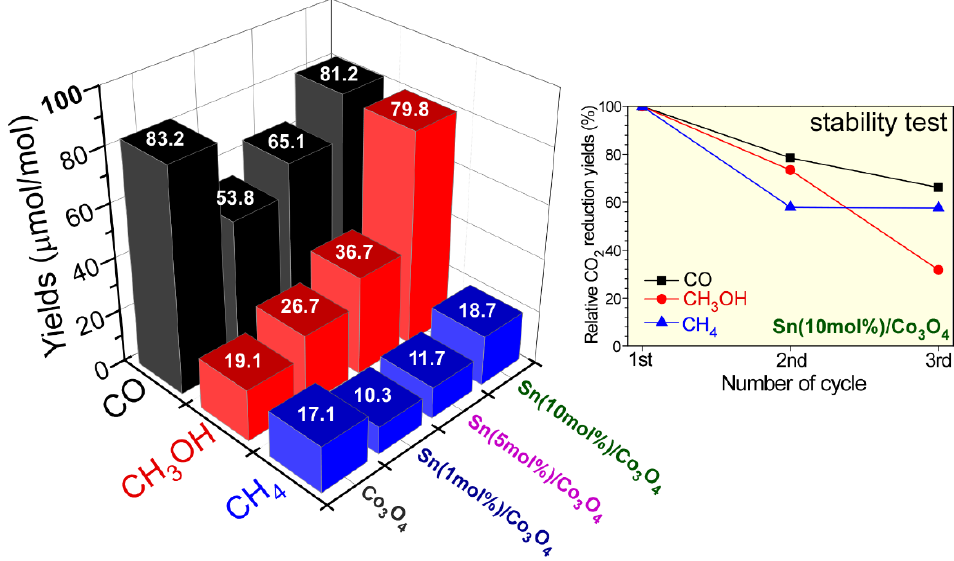
Figure 6. Photocatalytic total CO 2 reduction yields ( µ mol / mol) for the prepared samples with 0, 1, 5, and 10 mol% of sacrificial SnO 2 , and the stability test (right panel) for the 10 mol% sample.